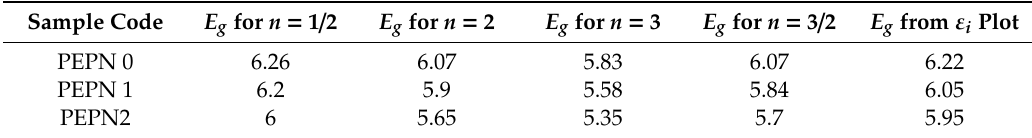
Figure 12. Plot of ( α h υ ) 1 / 2 vs. photon energy for pure PEO (PEPN0), PEO:CNDs (PEPN1), and PEO:CNDs:Ag (PEPN2) composite samples. Table 2. Estimated optical band gap from Tauc’s method [( α h υ ) 1 / n vs. h υ ] and optical dielectric loss